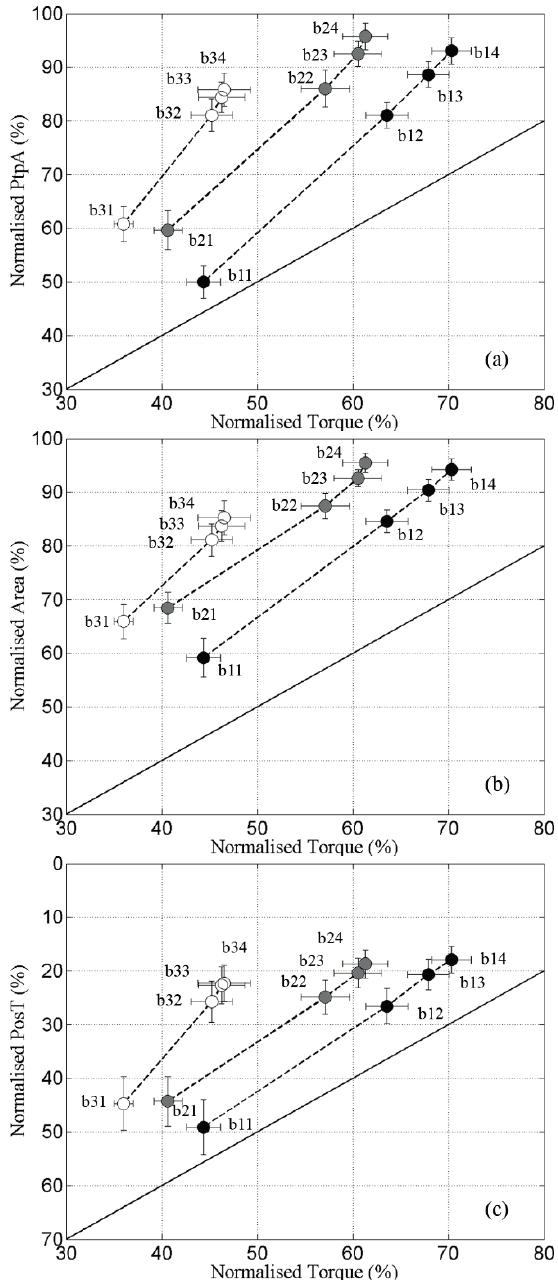
Figure 4. ( a ) PtpA × Torque ; ( b ) Area × Torque and ( c ) PosT × Torque curves obtained during r1 ( ● ), r2 ( ● ) and r3 ( ○ ). Note that in ( c ) the y axis was intentionally inverted as PosT recovered towards 0% as opposed to 100% in ( a ) and ( b ). The solid diagonal lines represent lines of identity. Data are mean ± standard